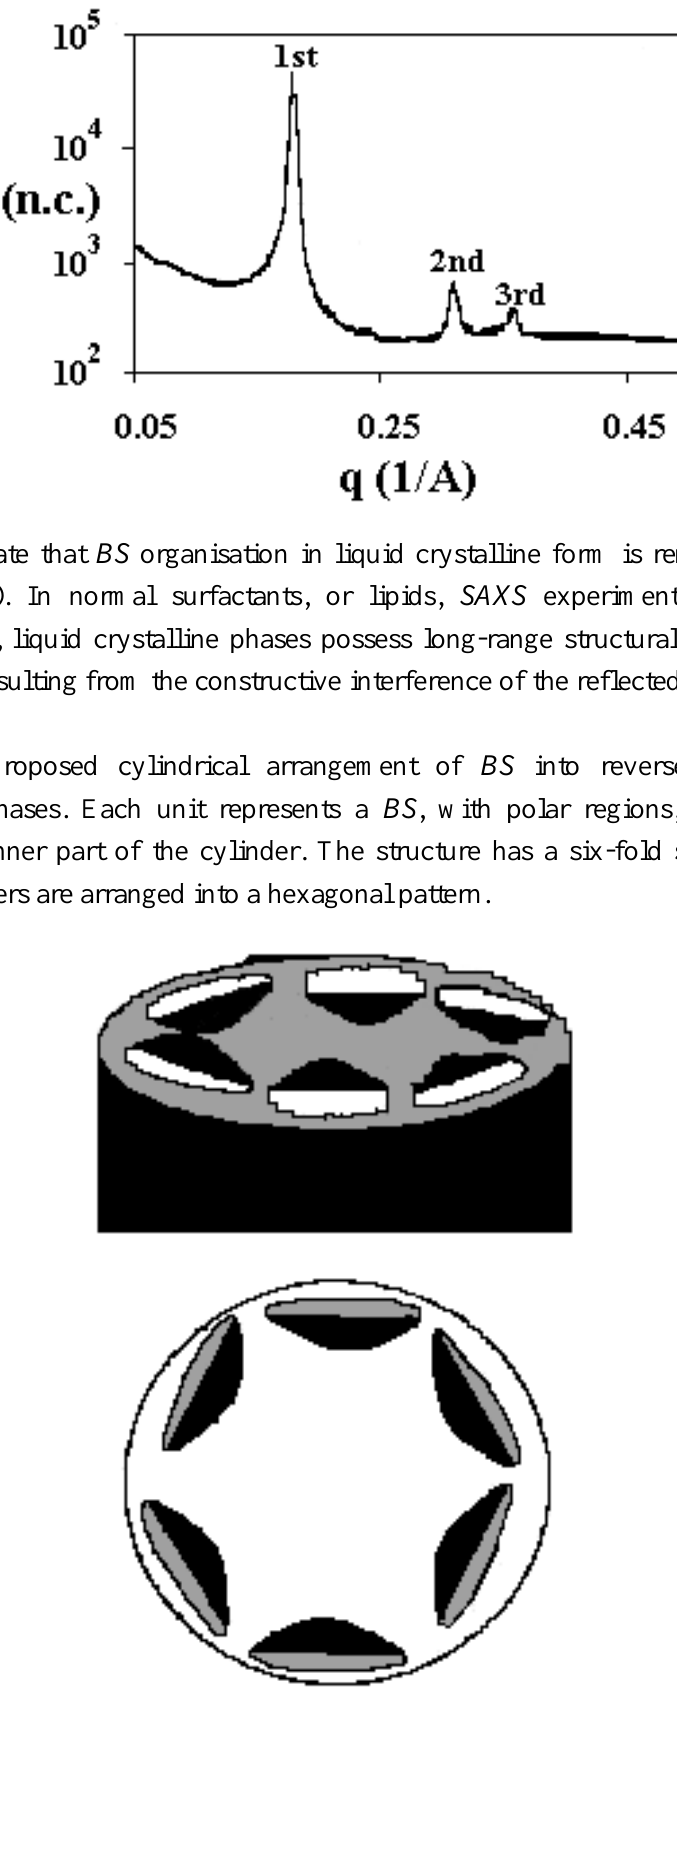
Figure 8. SAXS spectrum of a sample (48.4 wt%) in the water- NaTDC , at 25.0 °C. The presence of peaks, in the order 1:1.73:1.89, is representative of a hexagonal structure.